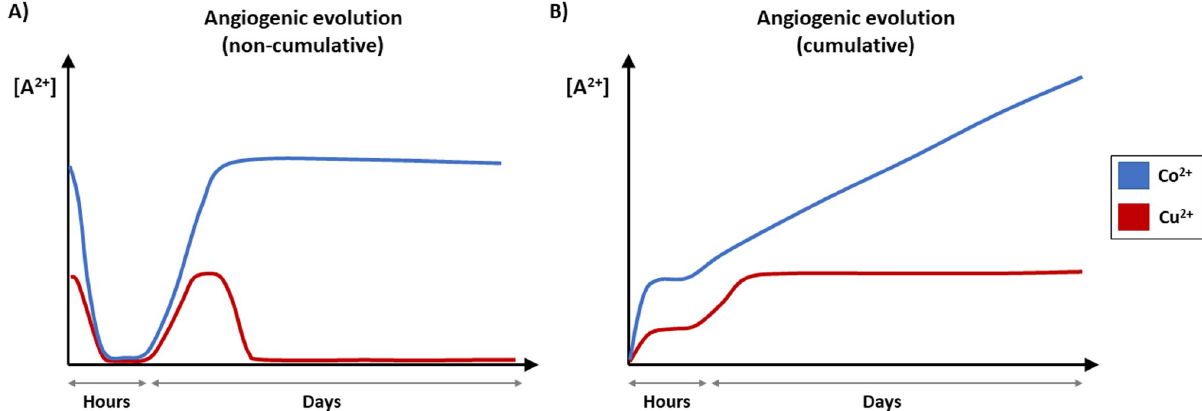
Fig 10. Schematic representation of angiogenic therapeutic doses of Cu 2+ and Co 2+ . (A) Profile of doses of Cu 2+ and Co 2+ that enhanced the angiogenic response within hours and days and (B) the corresponding cumulative release. Representation made based on VEGF and PECAM-1 gene expression and tubule formation assay